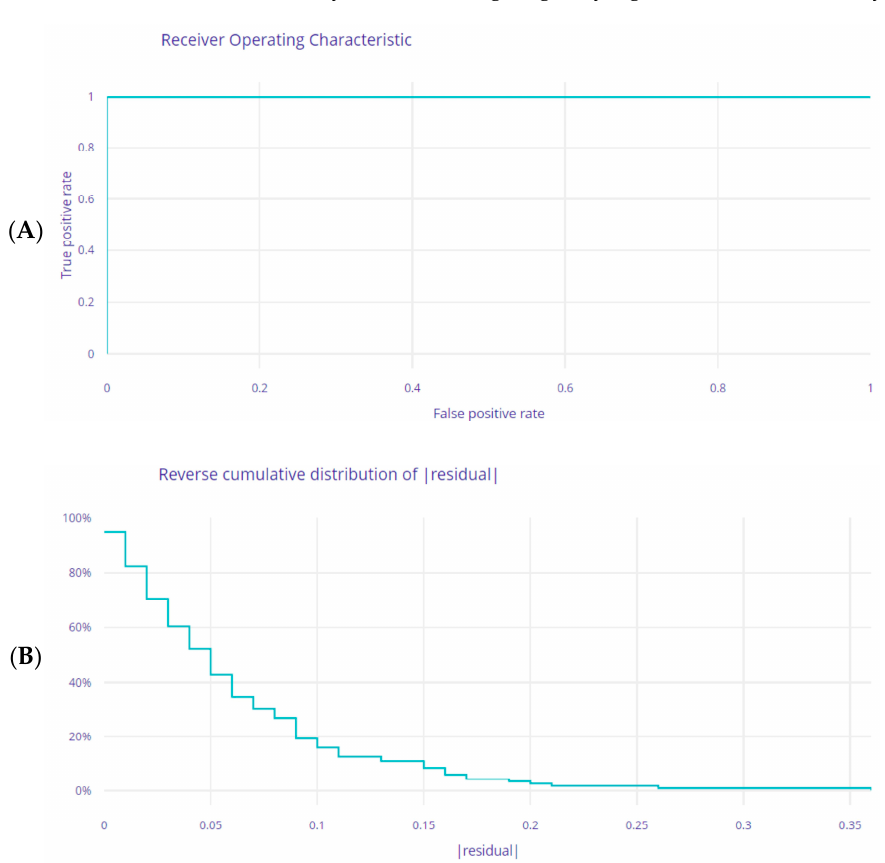
Figure 12. Model construction and feature screening using machine learning algorithms. ( A ) ROC curve of random forest model construction with a residual value of 1. ( B ) The reverse cumulative distribution curve plot to show the residual distribution of the random forest model.